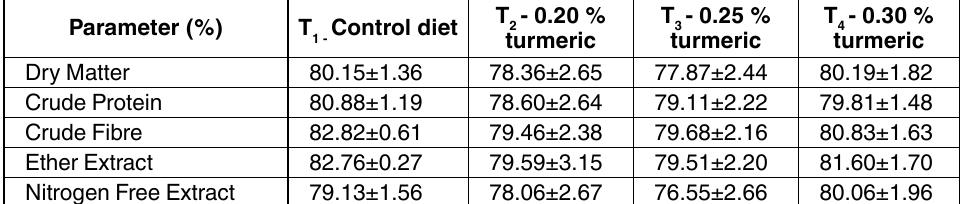
Table 3. Effect of turmeric powder on nutrient digestibility of broiler